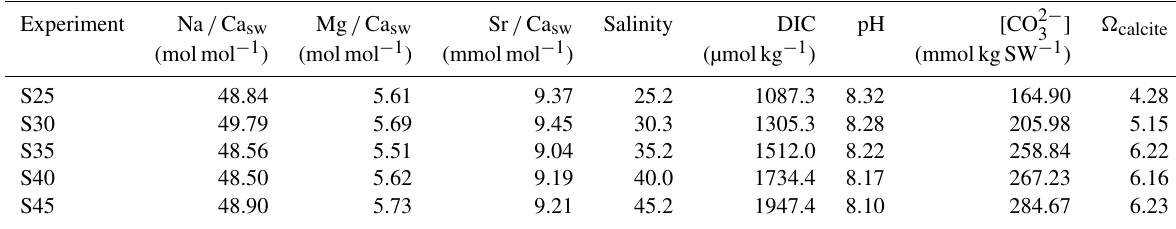
Table 1. Experiment culture media measurements per salinity condition. Carbonate ion concentrations and saturation state with respect to calcite (at 25 ◦ C) were calculated using CO2SYS (Van Heuven et al., 2011) and the equilibrium constants K1 and K2 of Mehrbach et al. (1973), as reformulated by Dickson and Millero (1987).